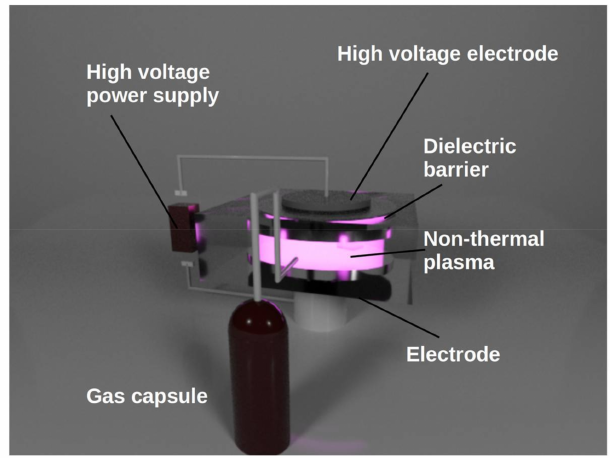
Figure 2. A schematic of dielectric barrier